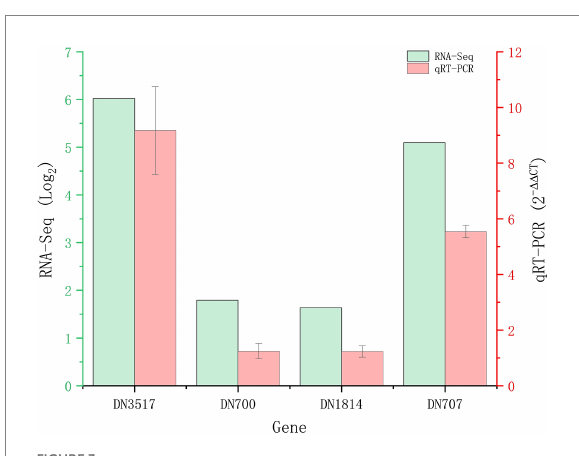
FIGURE 3 Validation of RNA-Seq results by quantitative real-time PCR (qRT- PCR). Four upregulated DEGs in Hypomyces chrysospermus were selected for